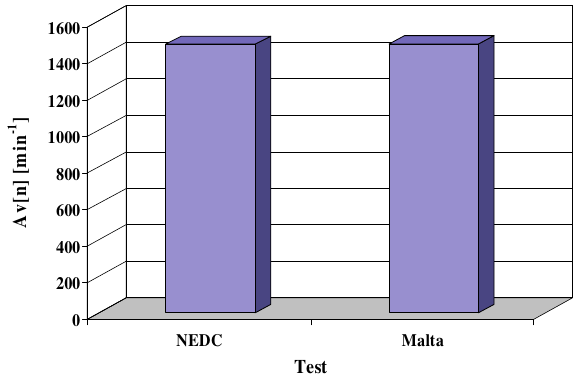
Fig. 1. Engine speed characteristic for the NEDC test